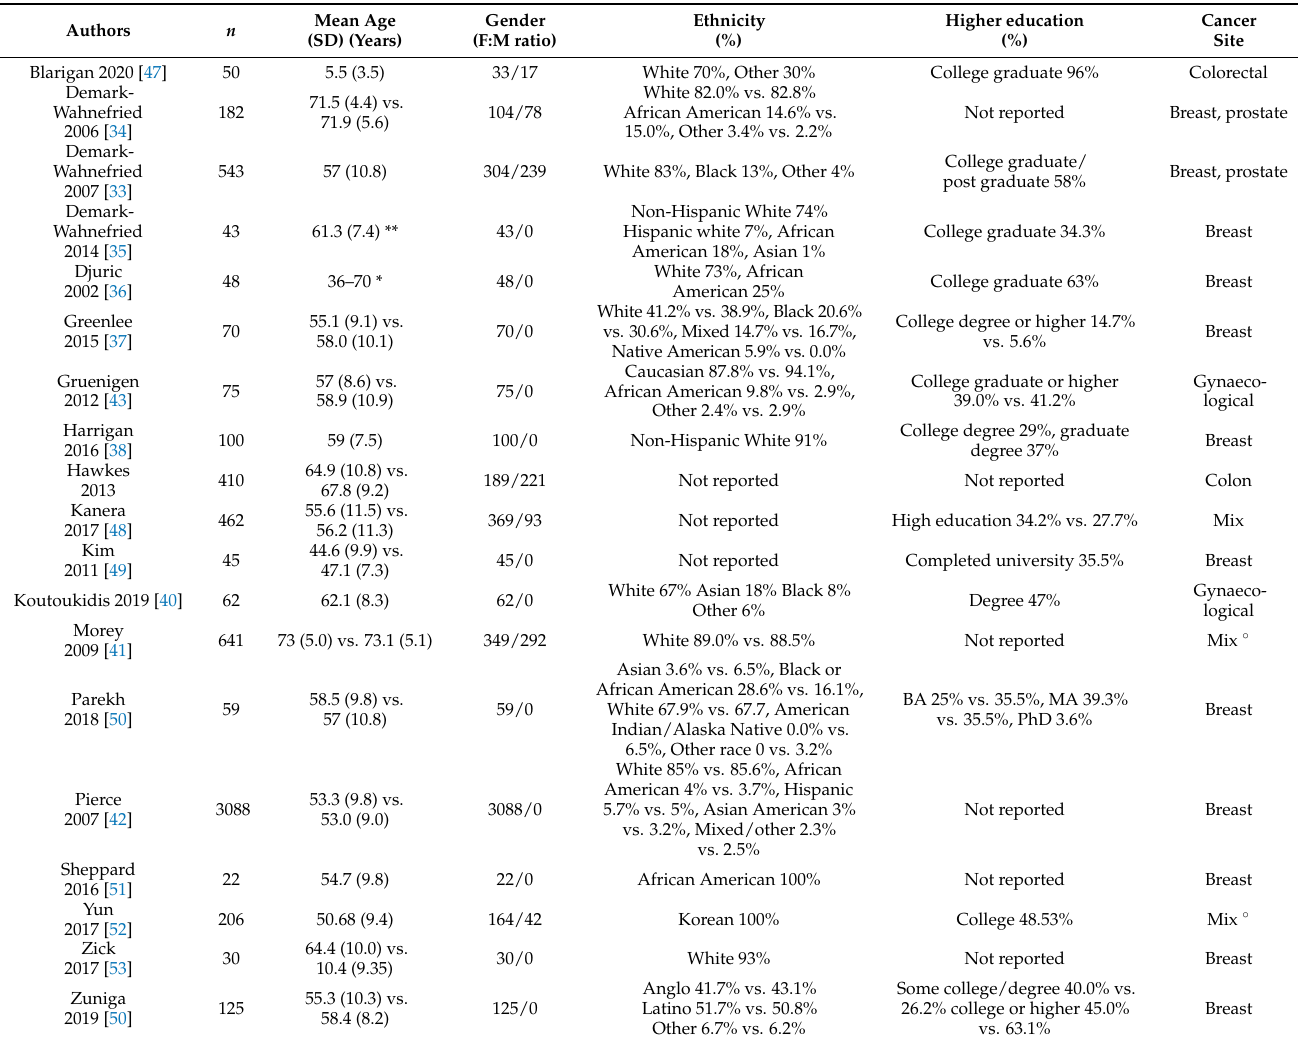
Table 1. Participant